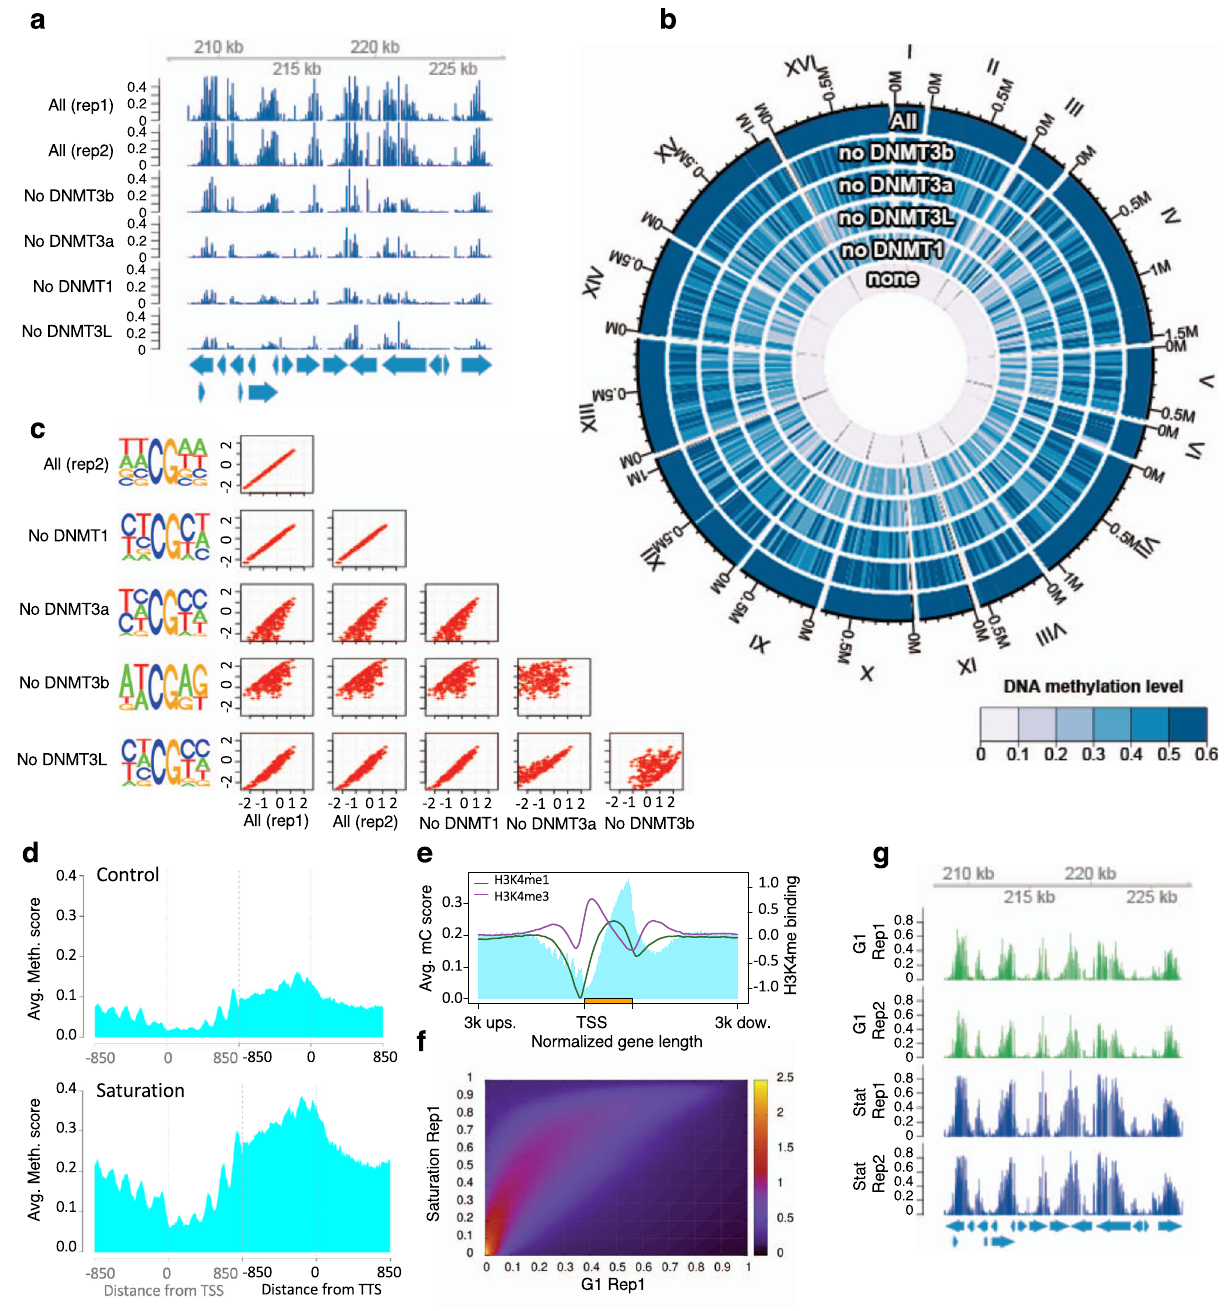
Fig. 1 Methylation pattern across several samples and along the gene body. a The pattern of methylation is conserved in all samples as illustrated for this 20 kb region of chromosome III (208,135..227,458) where the level of methylation at each position is represented for two samples with the four DNMTs expressed and four samples with each combination of 3 DNMTs. All the samples come from replicating cells, synchronized in G1. b Circular plot comparing DNA methylation for the samples in a and a control without methylation (None). Methylation levels decrease when one DNMT is missing, the strongest effect being without DNMT1 and the mildest effect when DNMT3b is not present. c Correlation between the sequence effect on methylation status among samples with different combinations of three DNMTs. Motif effects are estimated from logistic regression (for details see Methods) and correlation plots are produced for each pair of samples. Motifs have nearly the same effect in the two replicates with all DNMTs induced (correlation coef fi cient is cor = 0.999) and when DNMT1 (cor = 0.996) or DNMT3L (cor = 0.954) are removed. In contrast, the estimated effect of some motifs on methylation probability is different in samples lacking DNMT3a (cor = 0.793) or DNMT3b (cor = 0.631). The left panels show the sequence logo of the motifs preferentially methylated in each sample. d , f , g Comparison of methylation pattern in samples in exponential phase and at saturation. d Average methylation level around TSS and TTS (850 bp upstream and downstream from each point). e Superposition of the pattern of DNA methylation and the pattern of H3K4 methylation along the average gene body (from 3 kb upstream TSS to 3 kb downstream TTS). DNA methylation preferentially occurs where H3K4 is not methylated. f Heatmap showing the correlation between methylation probabilities in samples in G1 and at saturation. g The pattern of methylation is conserved in samples in G1 and samples at saturation as illustrated for this 20 Kb region of chromosome III (208,135..227,458) where the level of methylation at each position is represented for 2 replicas of each condition, G1 (in green) and saturation (in blue). NATURE COMMUNICATIONS| (2021) 12:3243